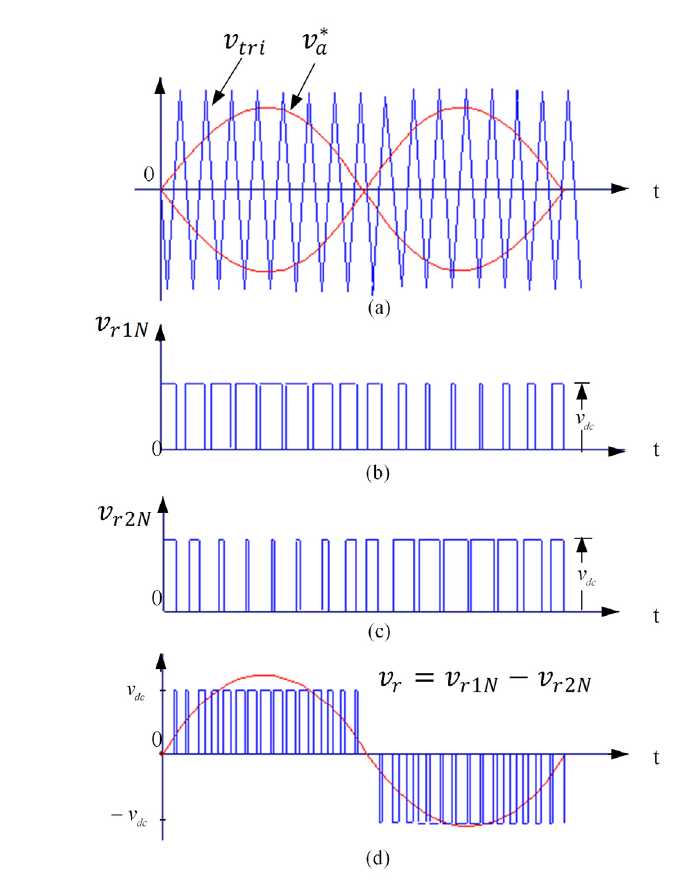
Figure 10. Switching pattern of the three-phase, six-leg inverter